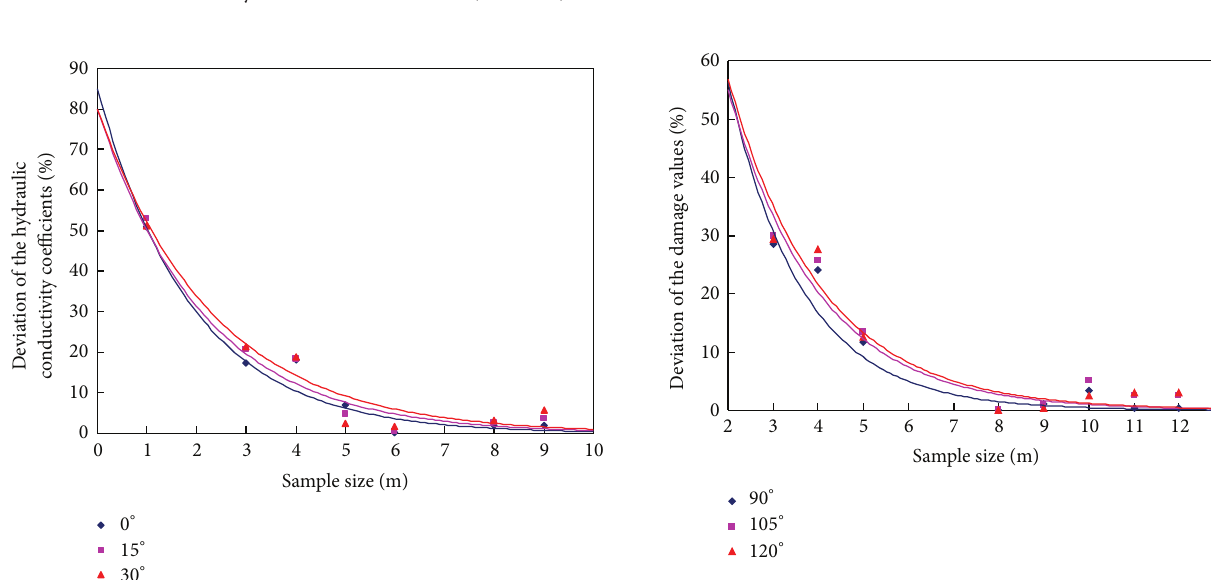
𝐺 𝑖𝑗 of the fracture